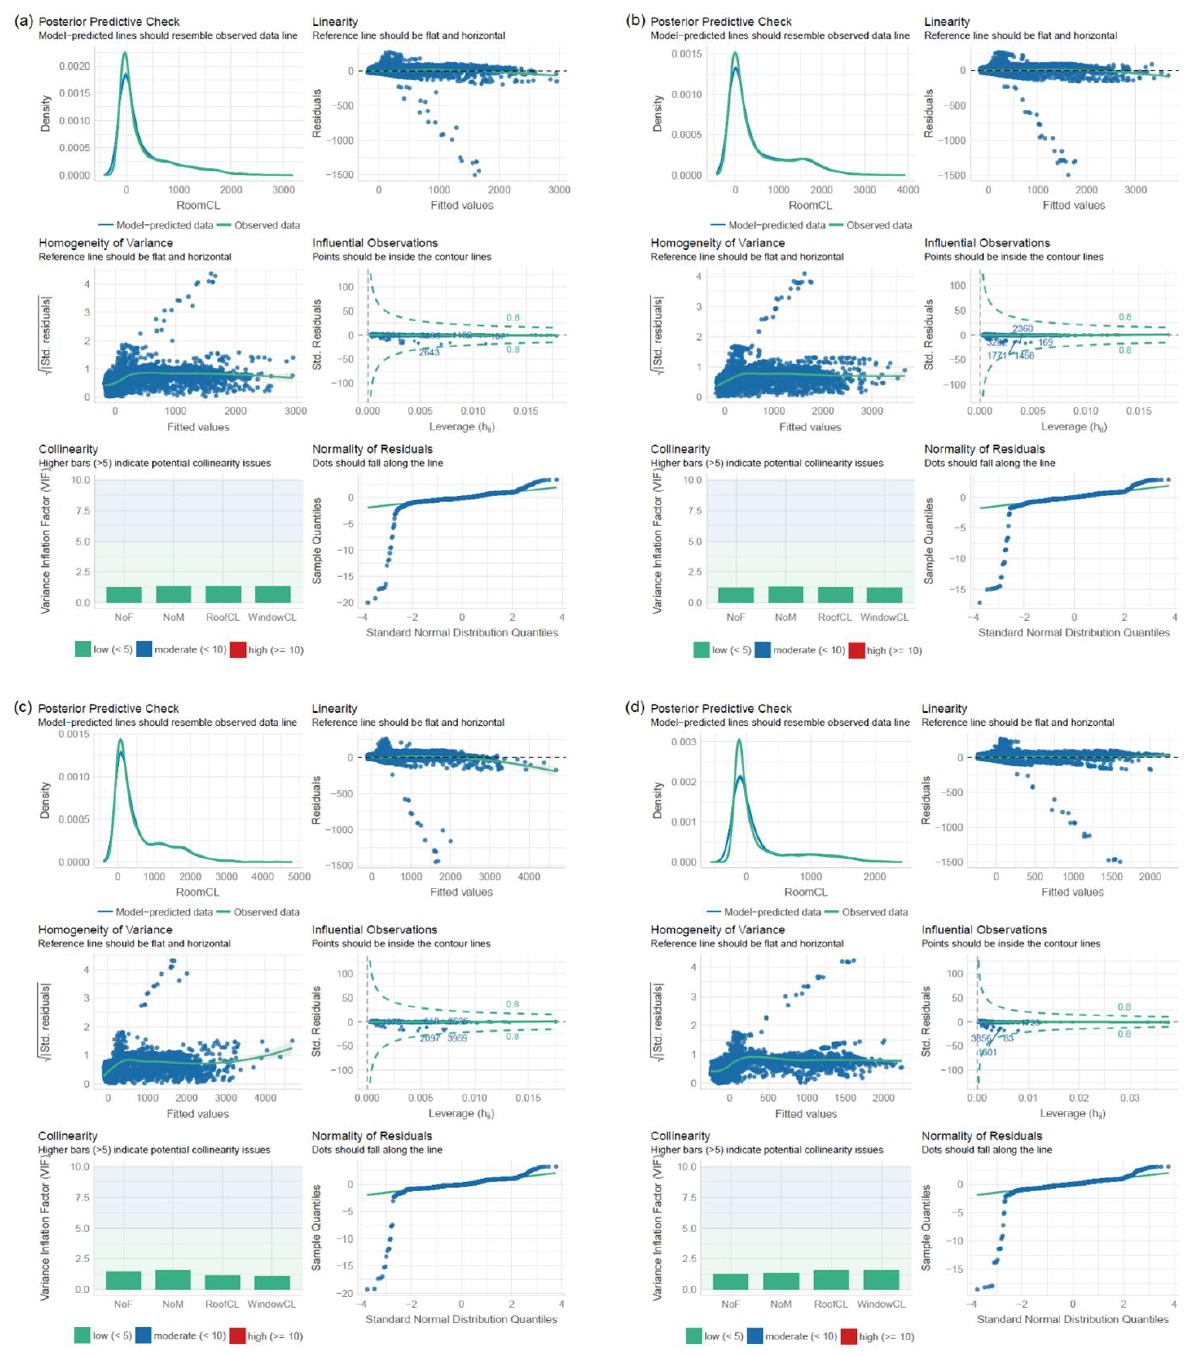
Figure 7. Visual check of models’ assumptions for the four seasons of the year: ( a ) autumn season; ( b ) spring season; ( c ) summer season; ( d ) winter season.